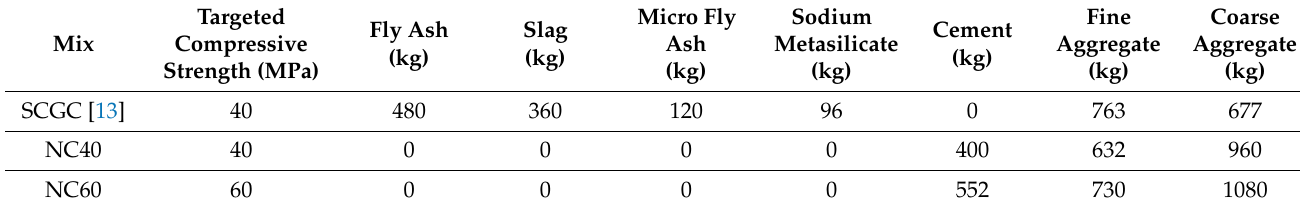
Table 3. Mix design for NC40, NC60 and SCGC concrete kg per 1 m 3 .